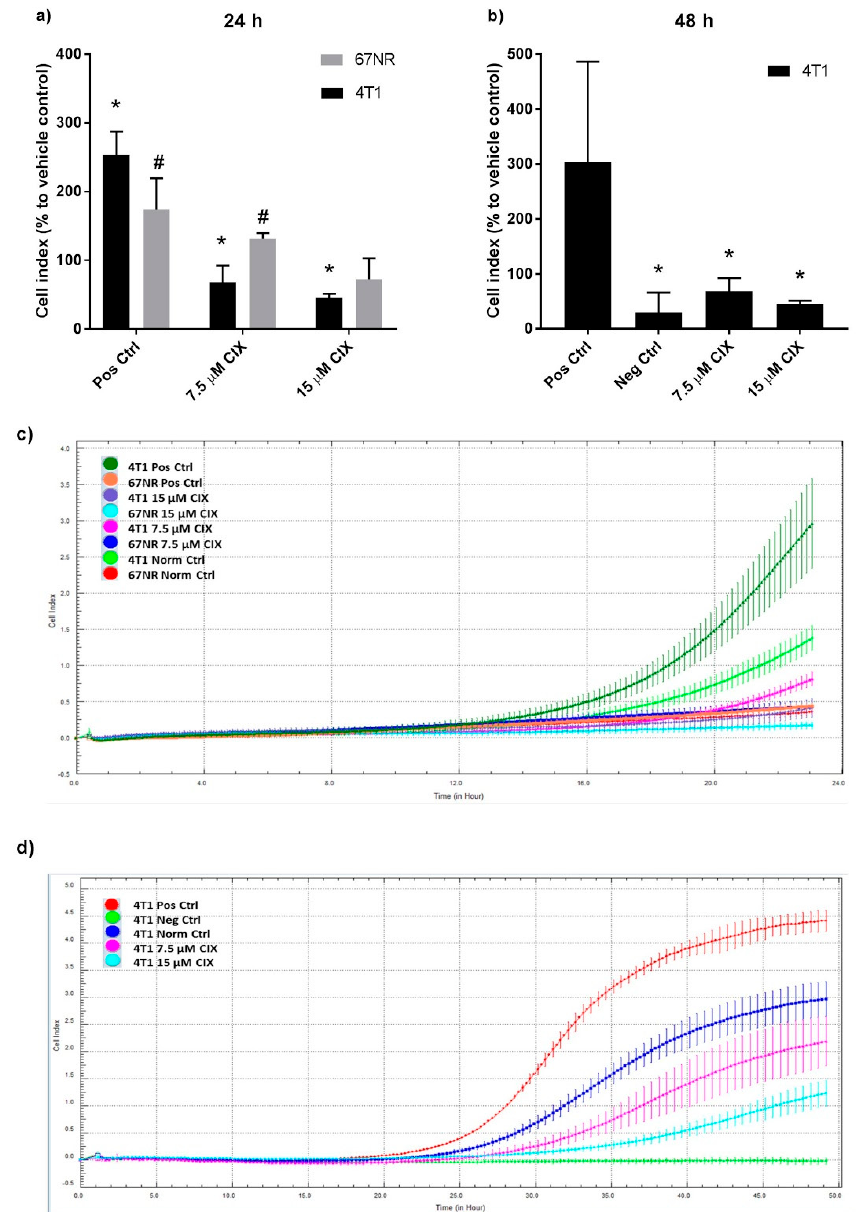
Figure 2. CIX inhibits migration in 4T1 cells, but not in 67NR cells. ( a ) Cell index (CI) related to vehicle control at the end of the 24 h treatment. Bars show the percentage mean ± SD of 3 experiments, normalized to vehicle control within experiment, n = 4 technical replicates per experiment ( b ) CI related to vehicle control at the end of 48 h treatment. Bars show the percentage mean ± SD of 3 experiments, normalized to vehicle control within experiment, n = 2 to 4 technical replicates per experiment. ( c ) CI curves for 67NR and 4T1 over 24 h. Each curve shows mean CI ± SD of n = 4 technical replicates. Representative experiment of n = 3 distinct experiments. ( d ) CI curves for 4T1 over 48 h. Each curve shows mean CI ± SD of n = 4 technical replicates for CIX treated groups and Norm Ctrl, n = 2 technical replicates for Pos Ctrl and Neg Ctrl. Representative experiment of n = 3 distinct experiments. ( a–d ) Norm Ctrl: Normal (vehicle) control. Norm Ctrl and all treated samples were subjected to 5% FBS in lower wells. Pos Ctrl: Positive control (high chemoattractant, 10% FBS in lower wells). Neg Ctrl: Negative control (0.5% FBS in lower wells). * p < 0.05 vs. 4T1 Norm Ctrl, # p < 0.05 vs. 67NR Norm